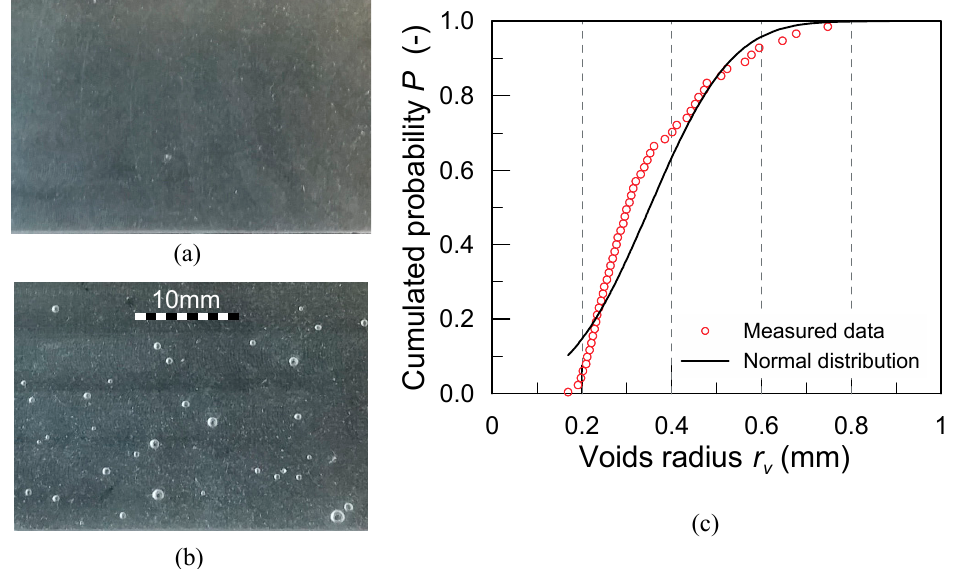
Figure 8. Images of the elastomeric material employed in specimens EC1–EC4 and D1–D4. Detail of the material ( a ) without and ( b ) with intrinsic defects. ( c ) Distribution of the void size cumulated probability.